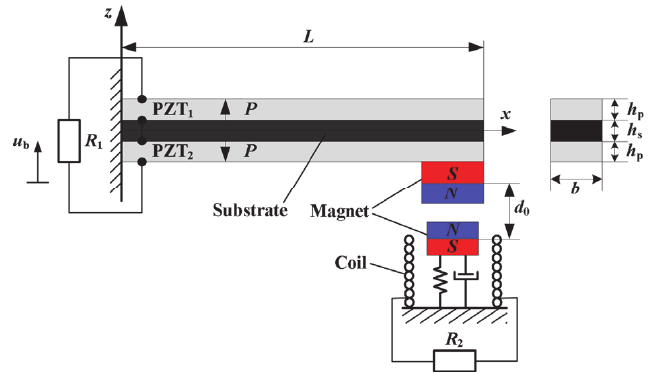
Figure 1. Schematic diagram of the proposed hybrid energy harvester.